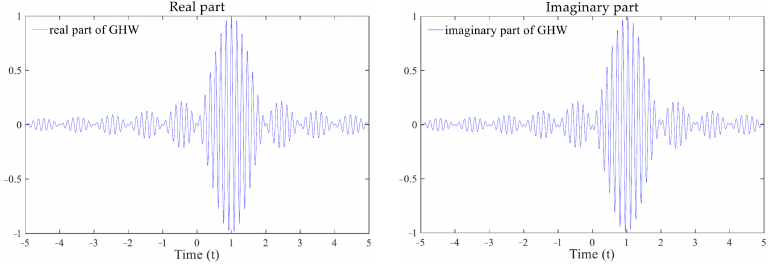
Figure 3. Real and imaginary parts of GHW at n = 7, m = 6, Δ = 1, k = 1. In fact, from the expression of Equation (7), the real part is an even function and the imaginary part is an odd function. Comparing Figures 1 and 2, it can be concluded that, as the bandwidth increases, the GHW waveform becomes narrower. The energy of GHW